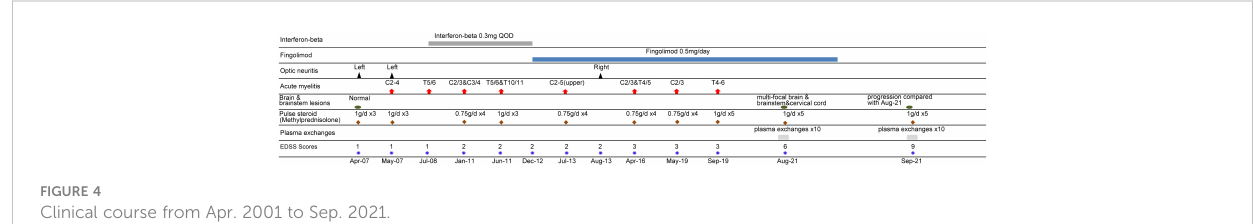
FIGURE 4 Clinical course from Apr. 2001 to Sep. 2021.